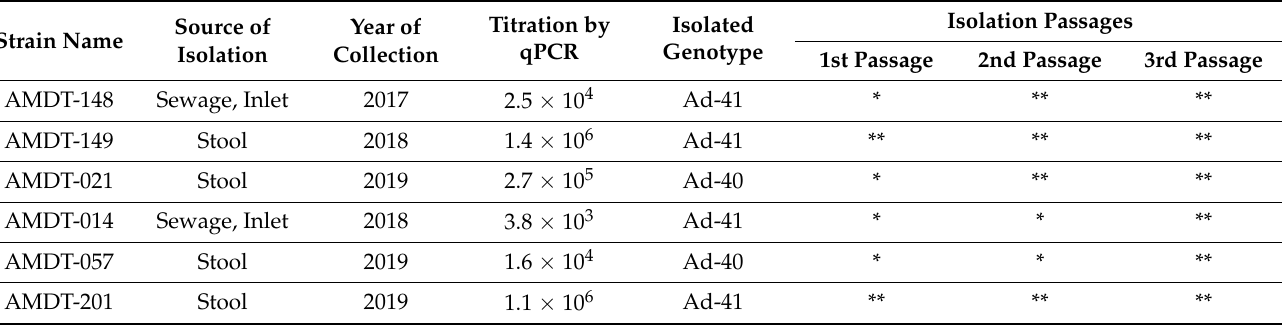
Table 5. The description of isolated samples by cell culture